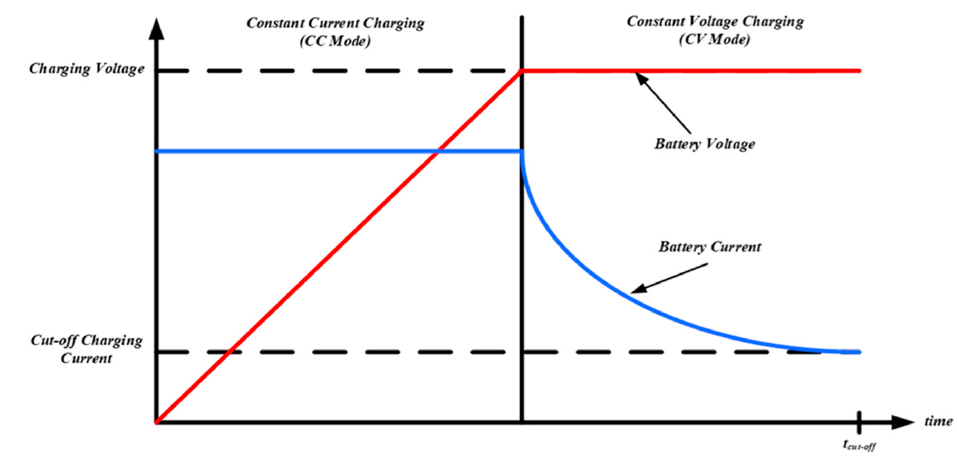
Figure 21. Constant-Current and Constant-Voltage (CC-CV) Charging.